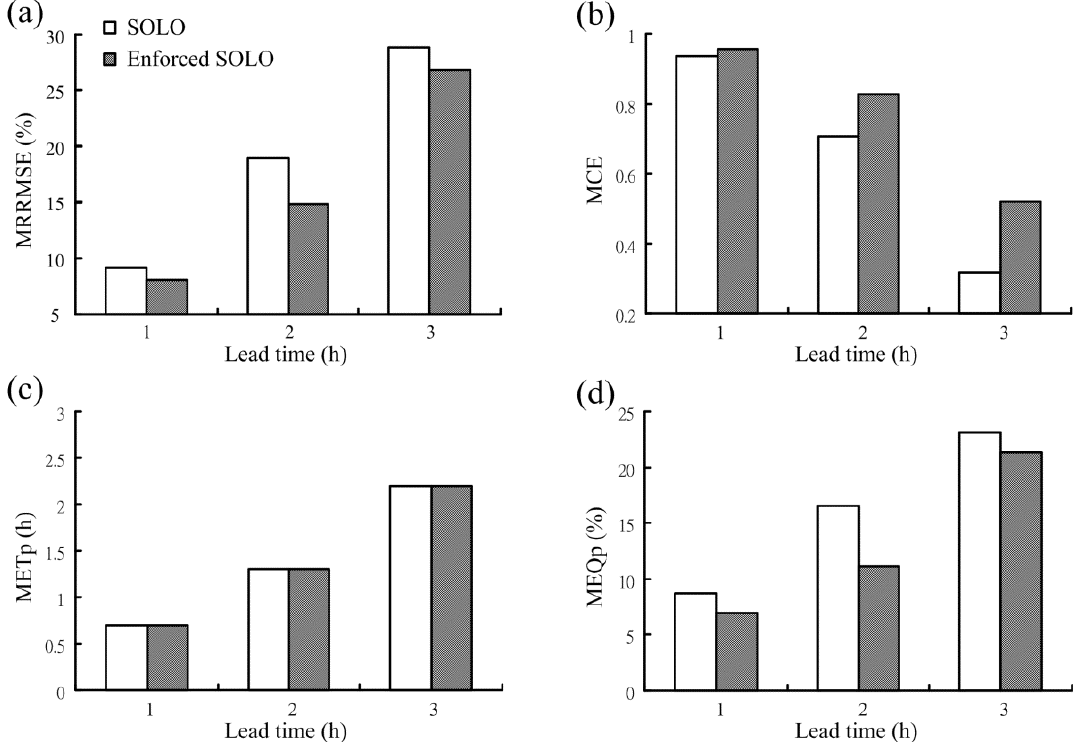
Figure 5. Performance comparison of the SOLO and the enforced SOLO models: ( a ) MRRMSE ; ( b ) MCE ; ( c ) MET p and ( d ) MEQ p